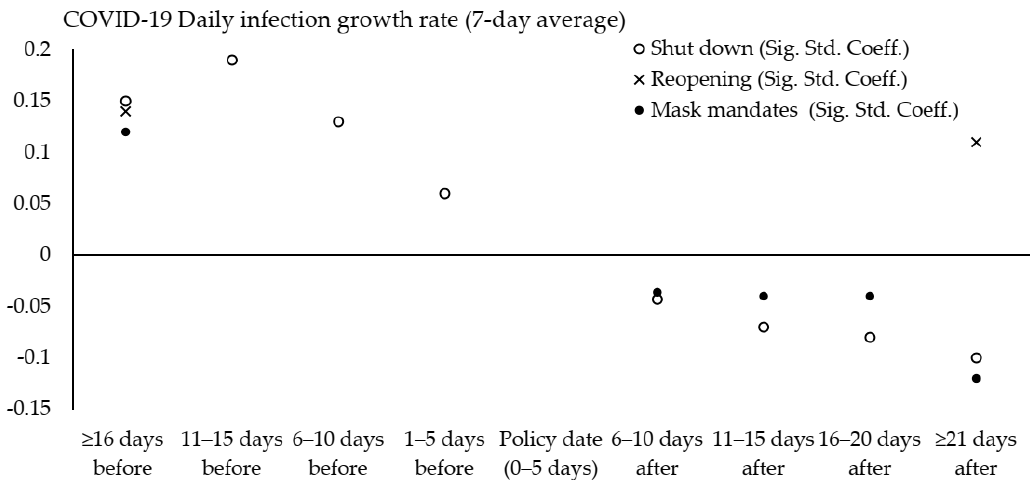
Figure 2. Relation between state policies and COVID-19 daily infection growth rate before / after implementation. Source: significant coe ffi cient results from Table 3; 50 US states; February